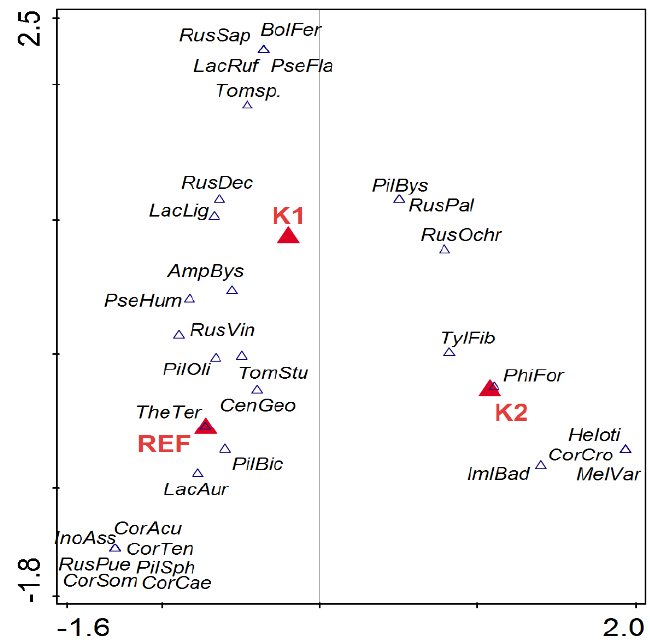
Figure 5. CCA analysis of ECM species composition of Norway spruce seedlings. Forest type was used as passive explanatory variable. K1, forest attacked by bark beetle; K2 forest destroyed by bark